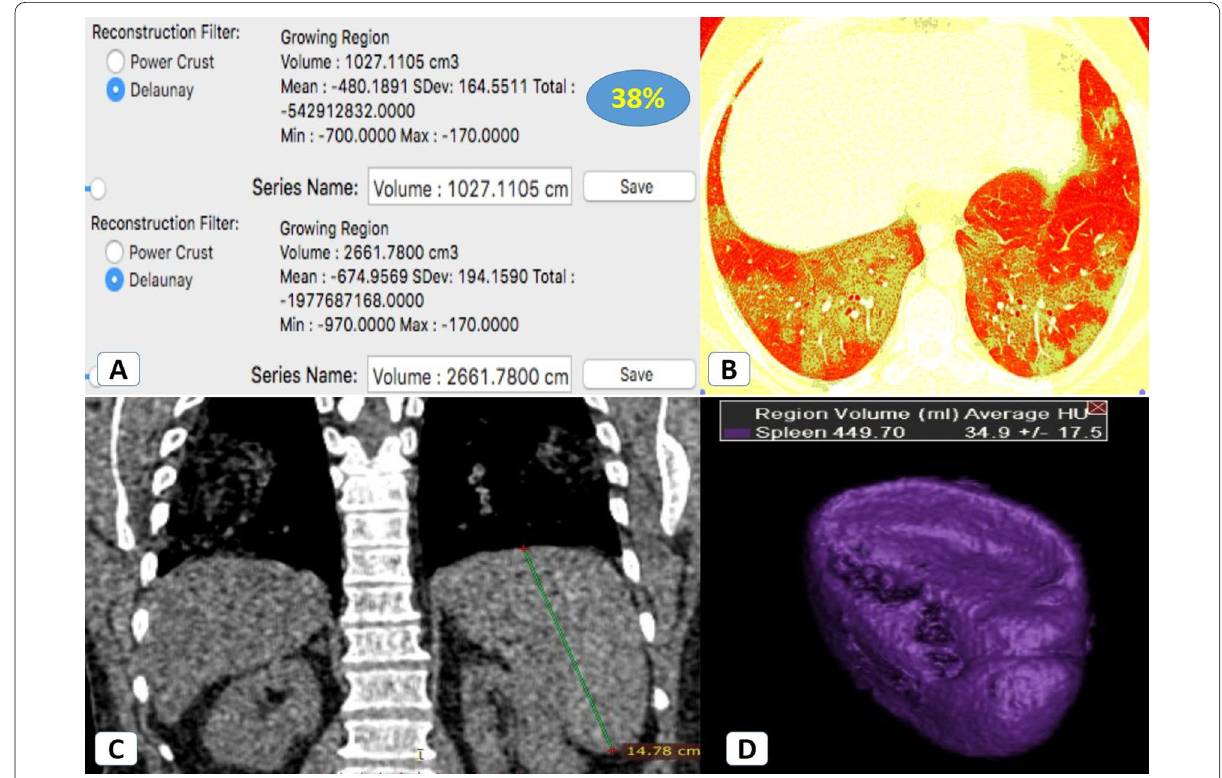
Fig. 4 Splenomegaly in a 58-year-old female patient with severe COVID-19 infection: A , B Volumetric CT assessment of the lung revealed 38% pathological lung involvement. C Coronal CT mediastinal window showed an increased craniocaudal bi-polar diameter of the spleen (14.8 cm). D CT volumetry of the spleen was 450